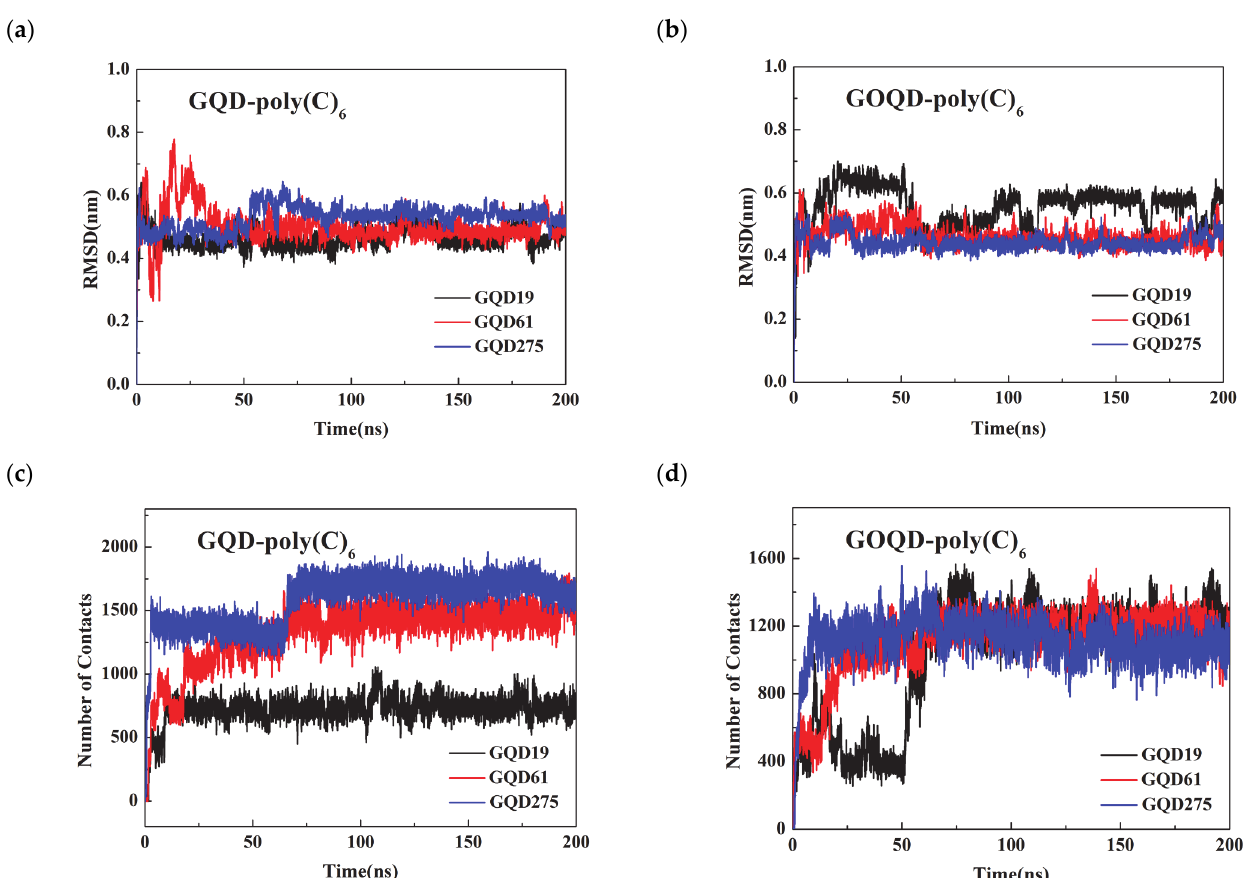
Figure 6. ( a ) The RMSD of poly(C) 6 absorbed on ( a ) GQDs and ( b ) GOQDs surface with different sizes versus the simulation time. The number of contacts between poly(C) 6 and ( c ) GQDs and ( d ) GOQDs with different sizes during the simulation.